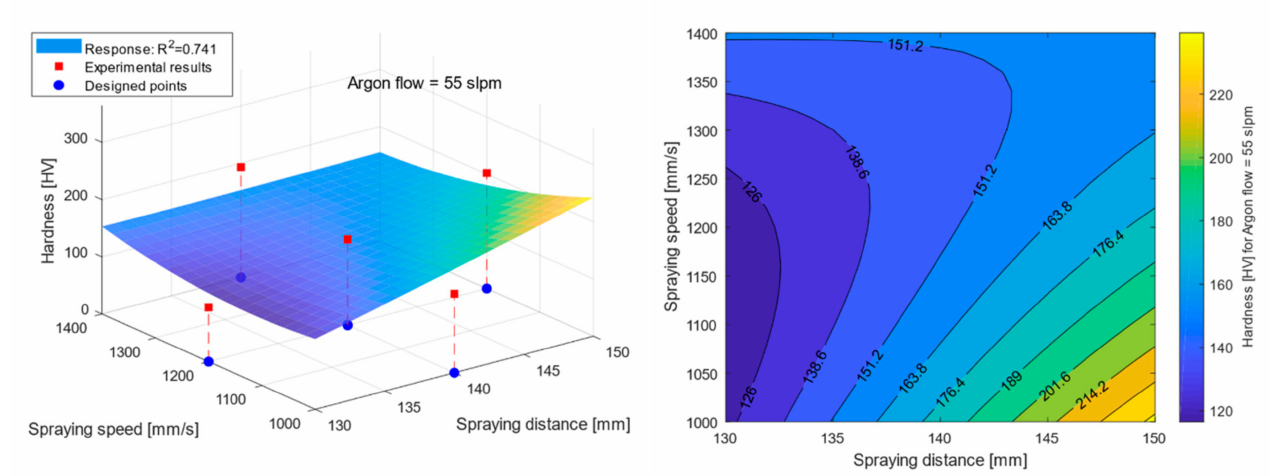
Figure 7. Response surface of the obtained hardness for a fixed argon flow rate of 55 slpm.